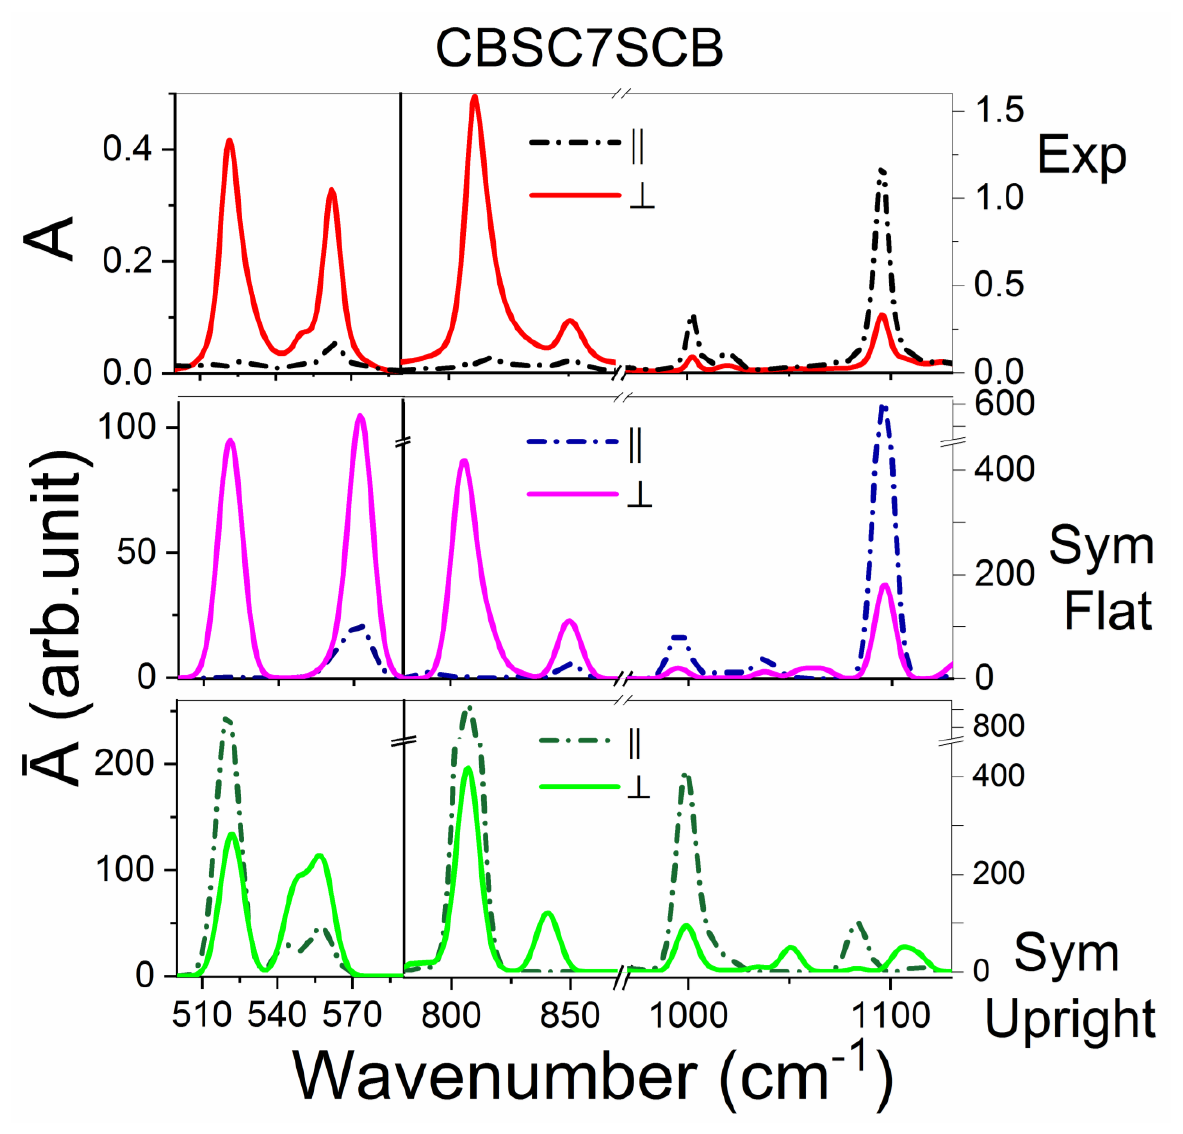
Figure 3. The comparison of the polarized experimental spectrum with the theoretical spectra (B3-LYP/6-311G (d,p)) for the CBSC7SCB dimer in the region of 500–1150 cm − 1 . A II –the parallel absorbance component in the z-axis direction of the molecular system, which coincided with the ordering axis of the sample. A ⏊ – the perpendicular absorbance component was perpendicular to the rubbing direction. Top Figures – experimental spectra of the nematic phase (370 K). Middle Figures – calculated spectra for a planar conformer (dihedral angles C Al -S-C Ar -C Ar = 0°). Bottom Figures – calculated spectra for an upright conformation (dihedral angles C Al -S-C Ar -C Ar = 90°). In this range, a low-intensity band with a wavenumber of about 1395 cm −1 was also observed, the direction of which was the dipole transition perpendicular to the long axis of the dimer. This band was assigned to the in-plane deformation of the C-H groups ( β CH ip CB). Differences between the two conformations for the benzene ring vibrations were also observed at 1600 cm −1 . In the experimental spectrum, this peak was split into two maxima with similar wavenumbers (1594 and 1604 cm −1 ), for which the intensity shares changed with temperature. In the nematic phase, both peaks had a similar intensity, while in the twist-bend phase, an increase in peak intensity was observed at a lower wave- number (1594 cm −1 ). For the F conformer, this vibration was observed at a lower wave- number, i.e., about 1595 cm −1 , while for the U conformer, it was observed at 1598 cm −1